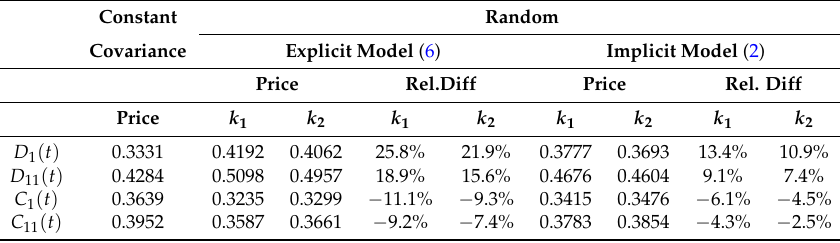
Table 4. Empirical price differences between constant and random